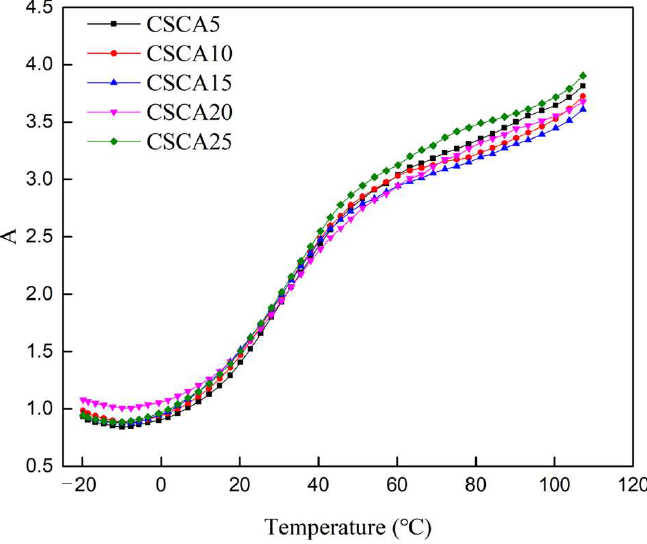
Figure 7. A values of core–shell structured WPCs.